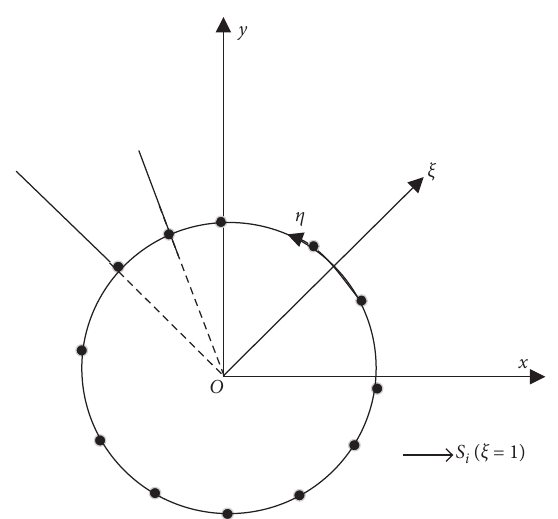
Figure 2: The scaled boundary